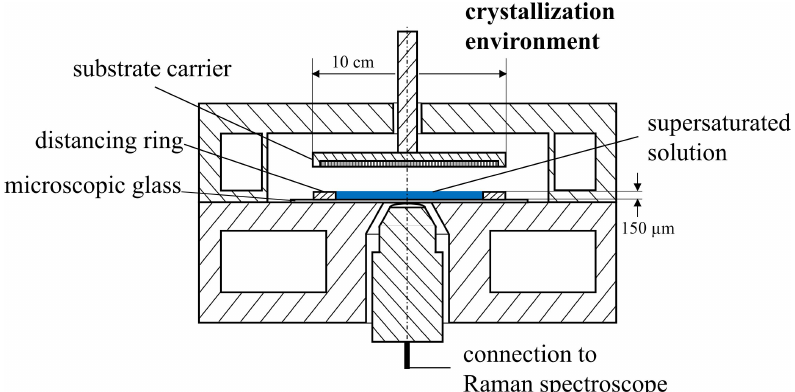
Figure 3. Experimental setup for dissolution and desupersaturation measurements comprising a crystallization environment and a Raman spectroscope. The inverse confocal Raman setup is adapted from Müller et al. [39], and can be reviewed in their